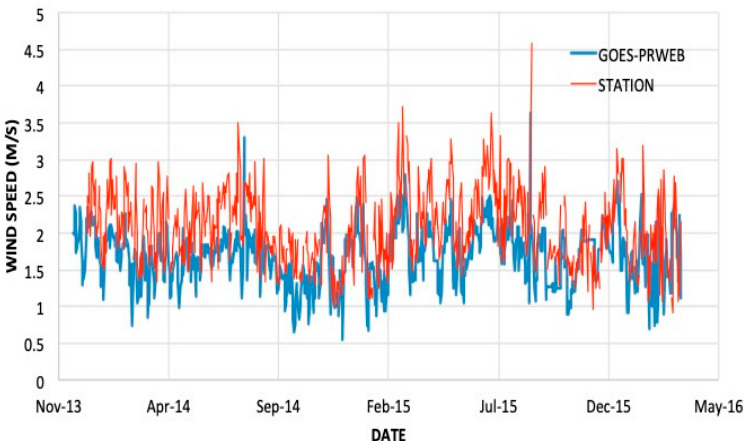
Figure A4. Modeled and observed u 2 from January 2014 to April 2016 at the UPR Agricultural Experimental Station near Juan Diaz, Puerto Rico.